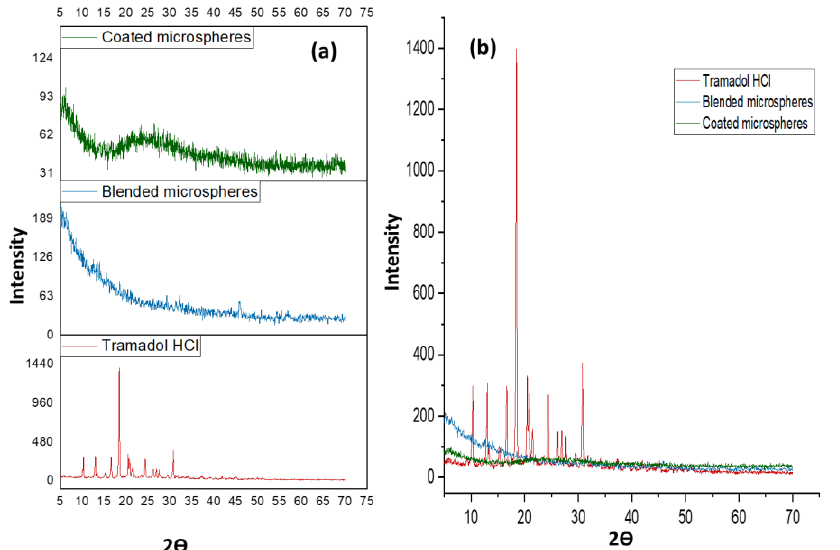
Figure 9. ( a ) XRD of pure TRHC, coated microspheres, blended microspheres; ( b ) Overlays of diffractograms showing a change in the intensity of peaks of TRHC in microspheres.